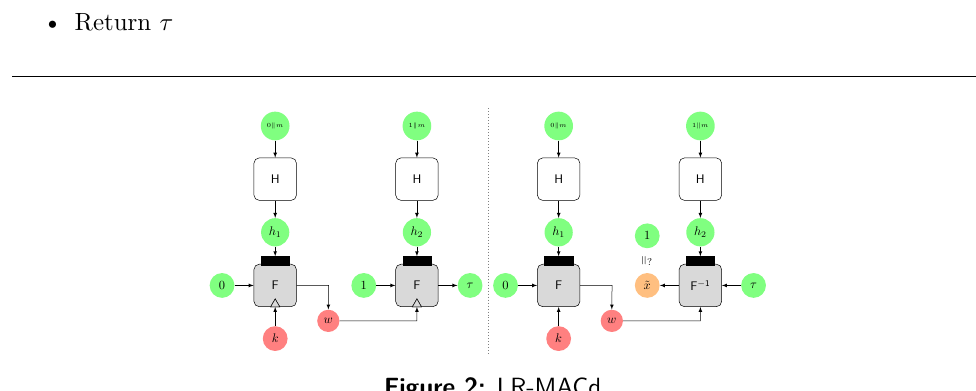
Figure 2: LR-MACd